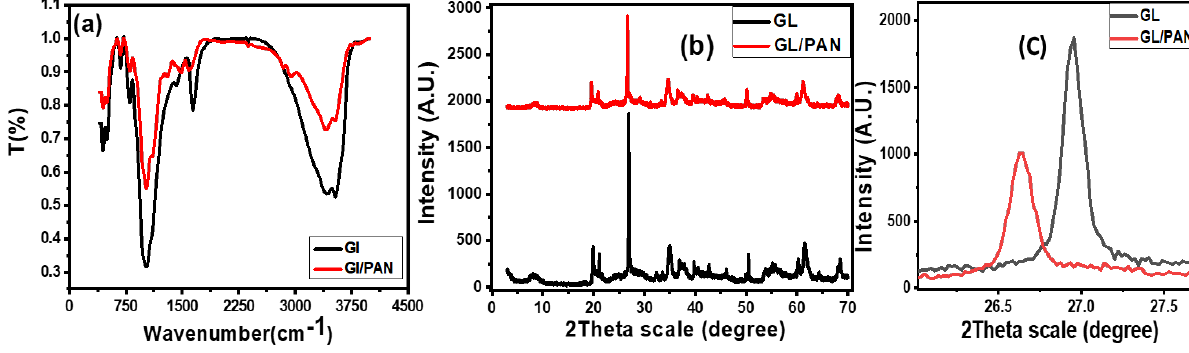
Figure 3. ( a ) F-TIR and ( b , c ) XRD charts of Gl and Gl/PAN